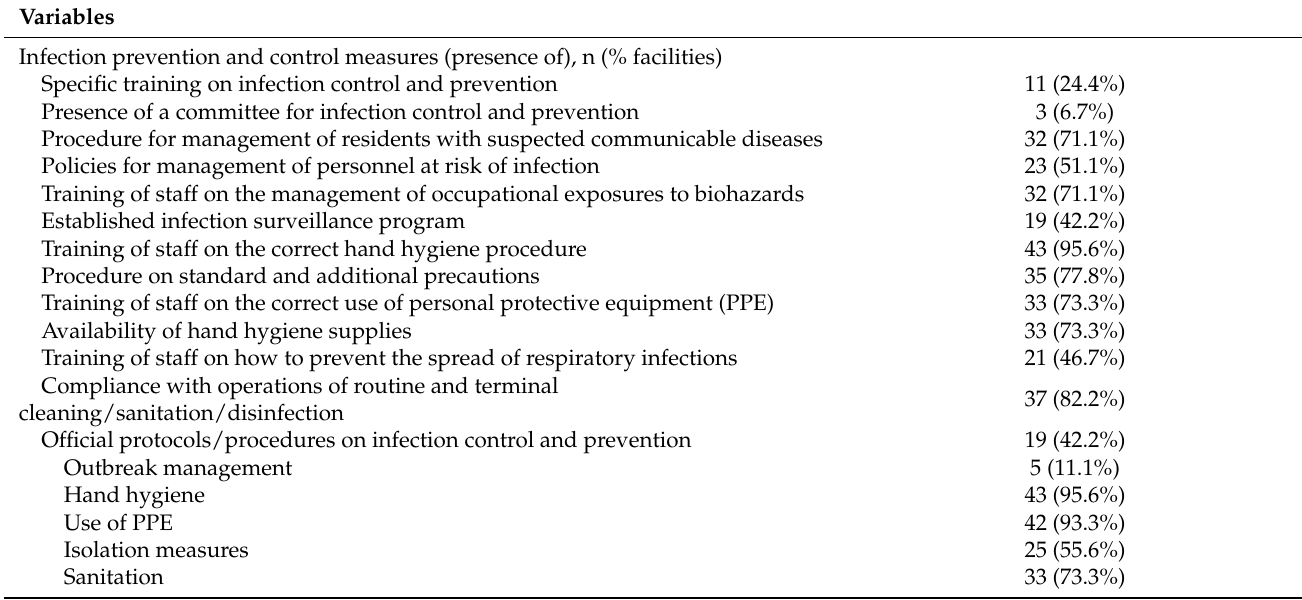
Table 1. Information on the infection prevention and control practices of the nursing homes retrieved by means of the infection prevention and control survey (N =